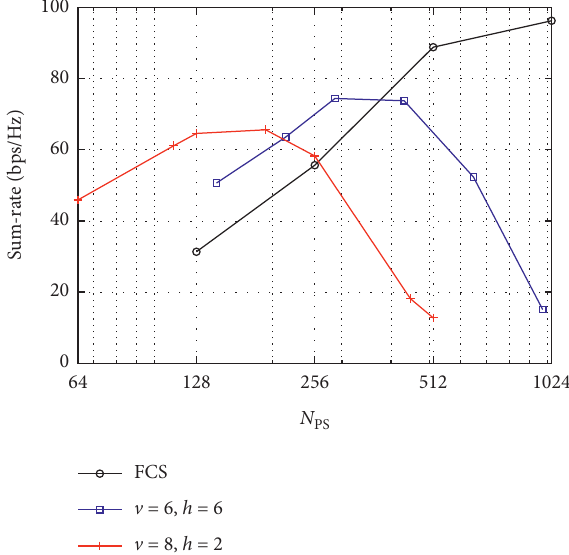
Figure 7: Sum-rate versus the number of phase